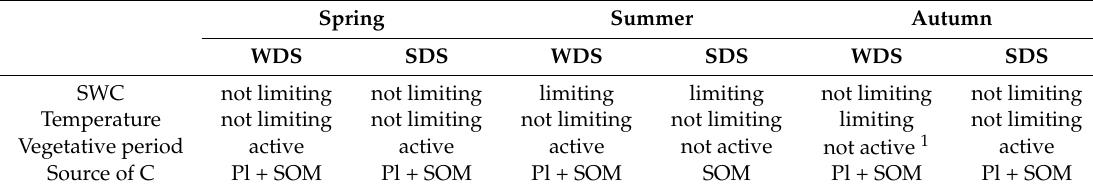
Table 2. General characteristics of climatic conditions (soil water content (SWC) and temperature), phenological status (vegetative period) and related source of C for soil CO 2 efflux (Pl = CO 2 from plant activity, i.e., sustained by plant photosynthesis; SOM = CO 2 from soil organic matter). Spring Summer Autumn WDS SDS WDS SDS WDS SDS SWC not limiting not limiting limiting limiting not limiting not limiting Temperature not limiting not limiting not limiting not limiting limiting not limiting Vegetative period active active active not active not active 1 active Source of C Pl + SOM Pl + SOM Pl + SOM SOM Pl + SOM Pl +